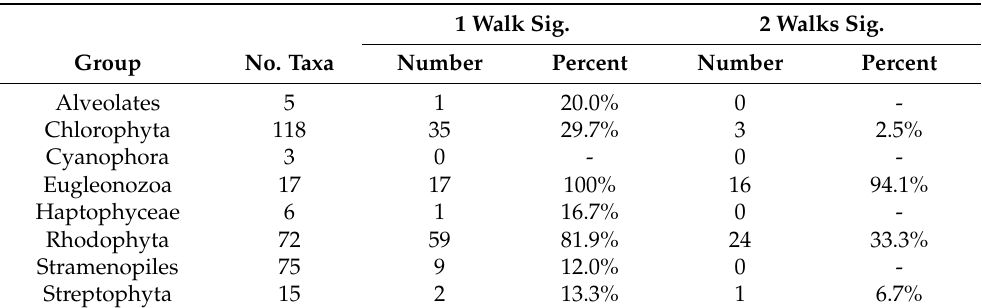
Table 1. Number of genomes showing significant walk deviation when relative location of I AT and I GC is not considered. 1 Walk Sig. 2 Walks Sig.